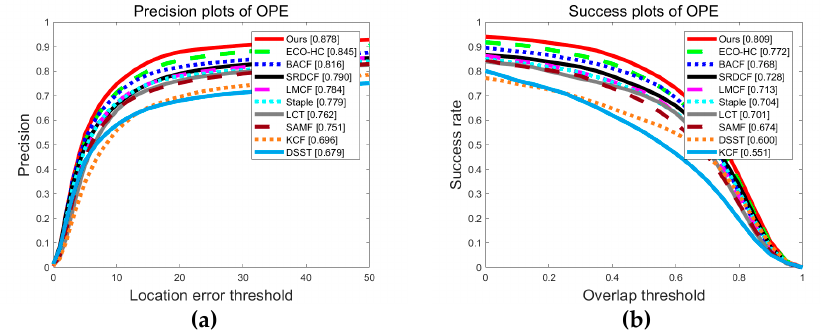
Figure 6. Experimental results for the representative ten trackers represented by ten different color curves: ( a ) The PP of the OPE on all sequences; ( b ) The SP of the OPE on all sequence. Table 3. Central position accuracy and average accuracy of representative ten trackers in 11 different attributes. Red, green, and blue, respectively, represent the top three trackers. Trackers